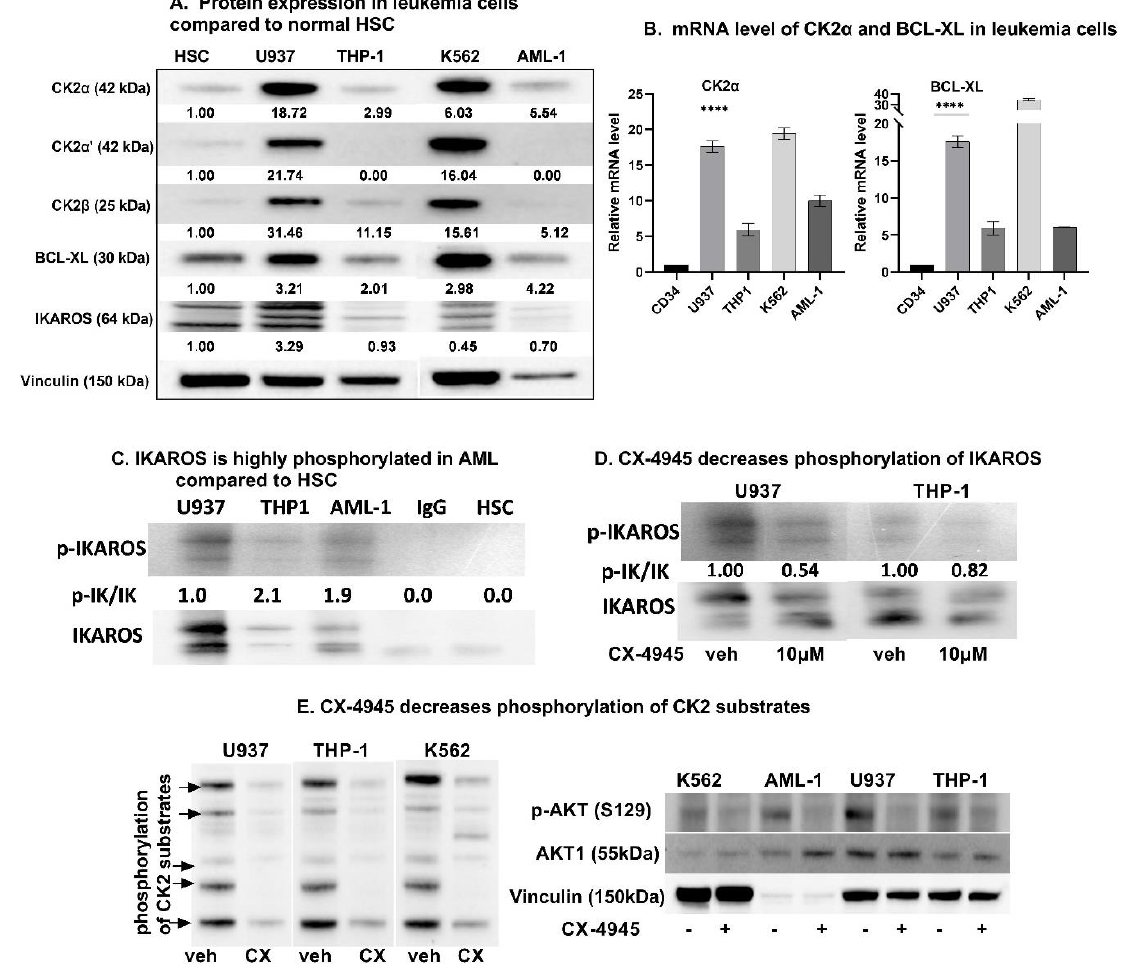
Figure 1. CK2 overexpression in AML cells causes IKAROS phosphorylation which is reversed by CK2 inhibitor, CX-4945. ( A ) Baseline protein levels of CK2α, CK2α’, CK2β, IKAROS and BCL-XL in the myeloid leukemia cell panel [U937, THP-1, K562, and primary AML cells (labelled AML-1) were measured by western blot and compared to CD34+ Hematopoietic Stem Cells (HSC). Multiple IKAROS bands represent Ikaros isoforms 1 and 2. ( B ) qRT-PCR showing mRNA level of CK2α and BCL-XL in various AML cells compared to CD34+ HSC. **** ( p < 0.0001). ( C ) Radio-blot showing increased Phosphorylated IKAROS (p-IKAROS) in AML cells compared to HSC. ( D ) Radio-immunoblot showing dose-dependent decrease in Phospho-IKAROS level following CX-4945 treatment. U937 and THP-1 were treated with 10 µM and AML-1 was treated with 5μM (IC50–3.791 μM) CX-4945 for 48 h. IC50 values of CX-4945 treated cells are shown in Figure S2. ( E ) Western blot showing decrease in amount of phosphorylated CK2 substrates with molecular masses of approximately 175, 120, 80, 70 and 56 kDa as indicated by arrows (left panel) and western blot showing phosphorylation extent of specific CK2 substrate, AKT1 at Ser129 (right panel).